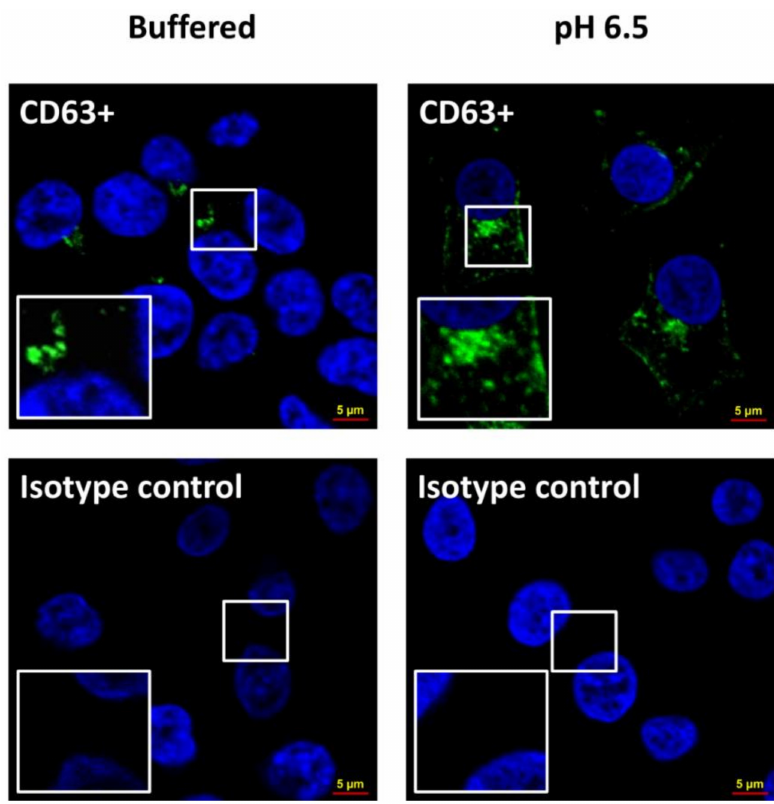
Figure 2. Confocal microscopy of tumor cells cultured in buffered and pH 6.5 conditions. The cells, after being fixed in 3% paraformaledehyde, were labeled with CD63 monoclonal antibody (MEM-259), and Alexa Fluor 488 with a concentration of 1:25 for 2 h at room temperature; then, they were labeled with diamidino-2-phenylindole (DAPI) and observed with a confocal microscope. ( Left ) In upper panel, tumor cells cultured in buffered conditions labeled with CD63; in lower panel, the same cells with isotype control. ( Right ) In upper panel, tumor cells cultured in pH 6.5 conditions labeled with CD63; in lower panel, the same cells with isotype